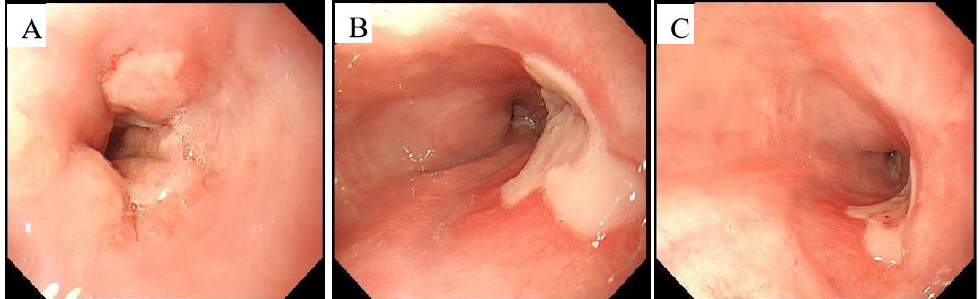
Figure 4. The findings of the second gastroscopy (after treatment) (equipment type: Olympus GIF- H260, Japan, Tokyo). ( A ) An ulcer (1.0 cm) in the dentate line. ( B , C ) An ulcer (2 × 1.0 cm) in the lower